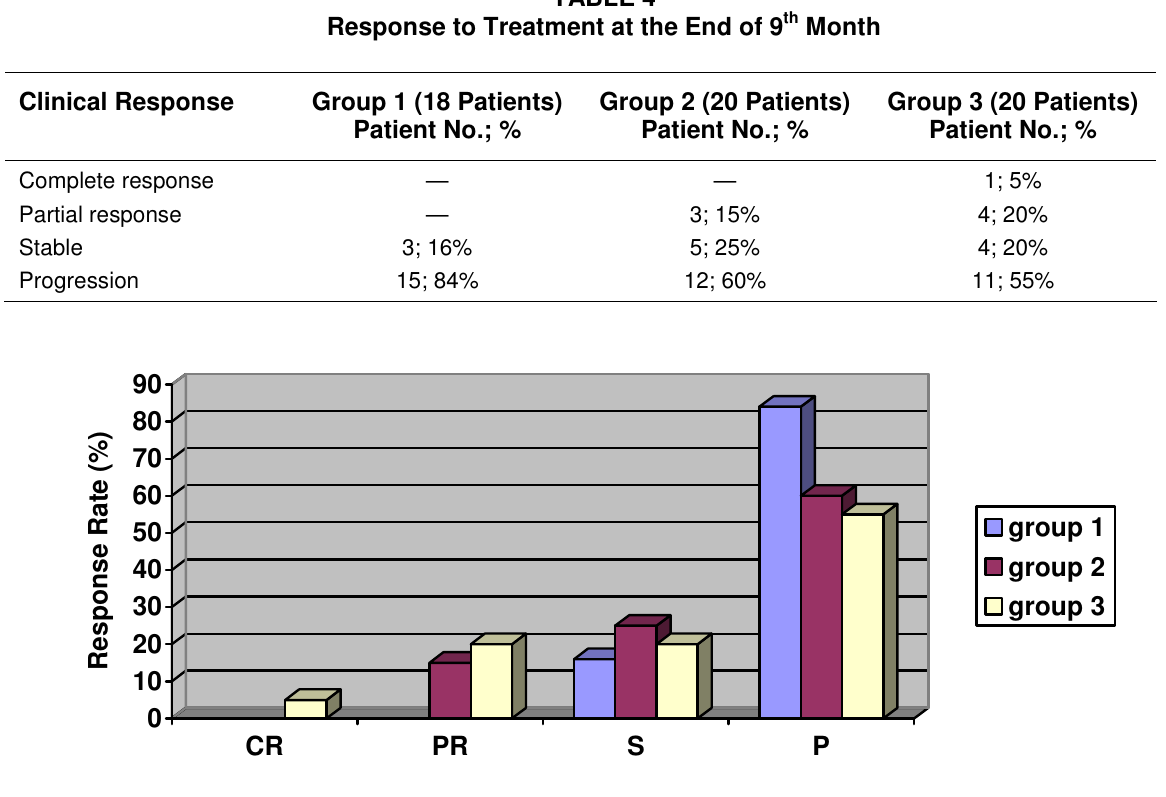
FIGURE 3 . Response to treatment at the end of the 9 th month with respect to treatment